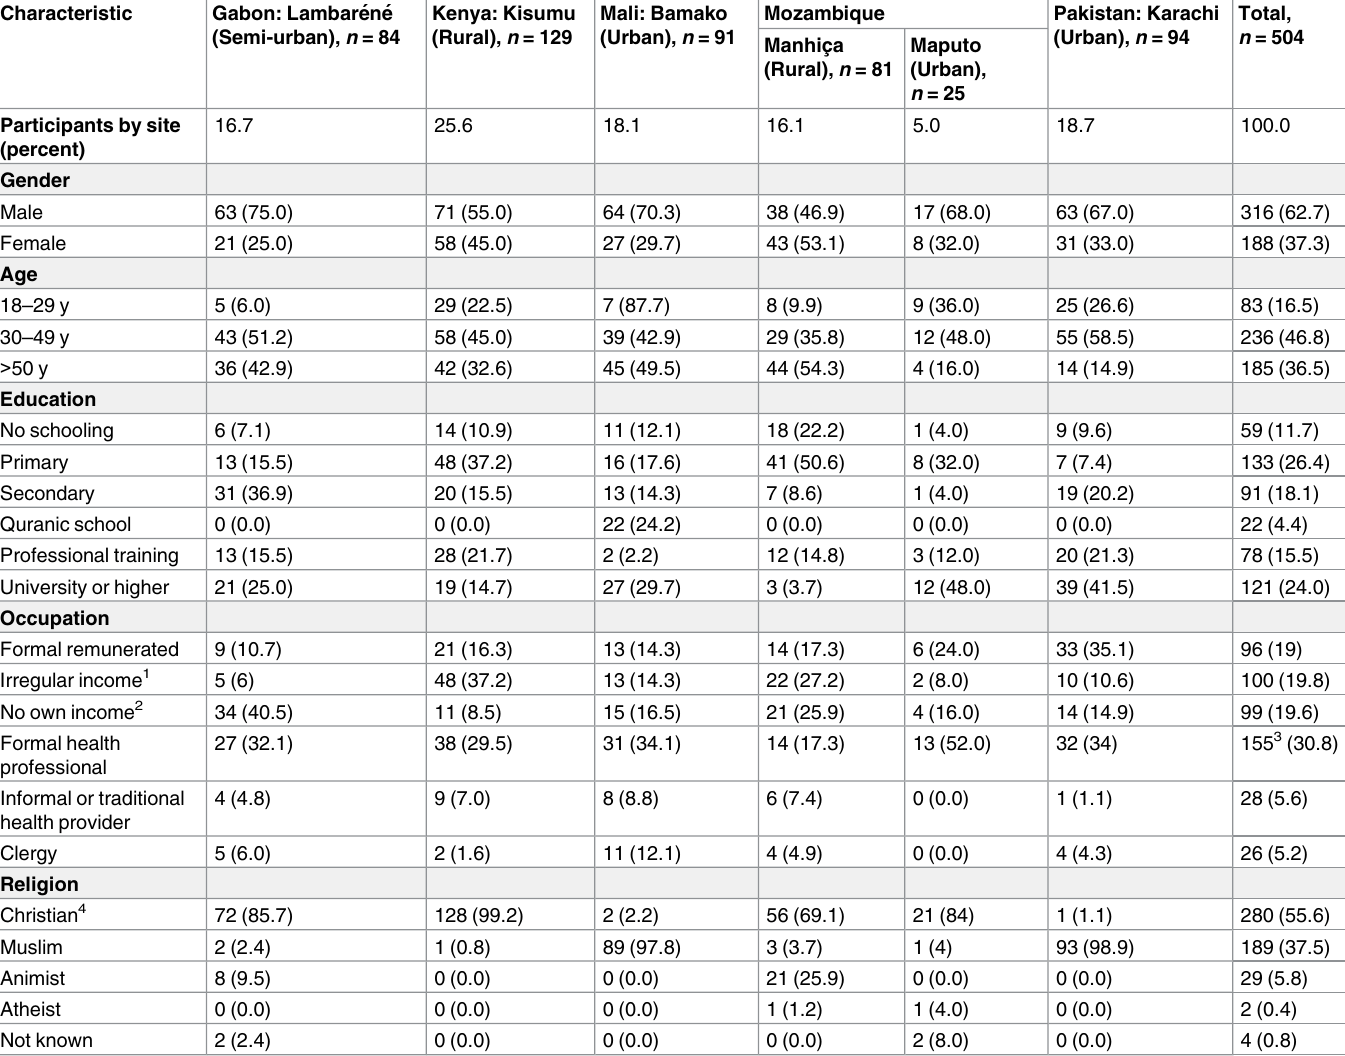
Table 2. Socio-demographic characteristics of